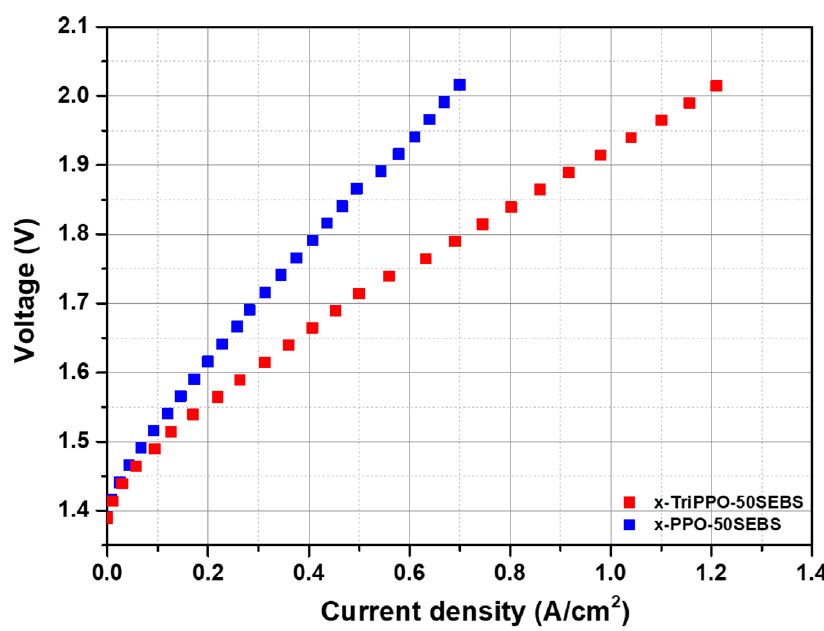
Figure 9. WE performance of the crosslinked PPO–SEBS